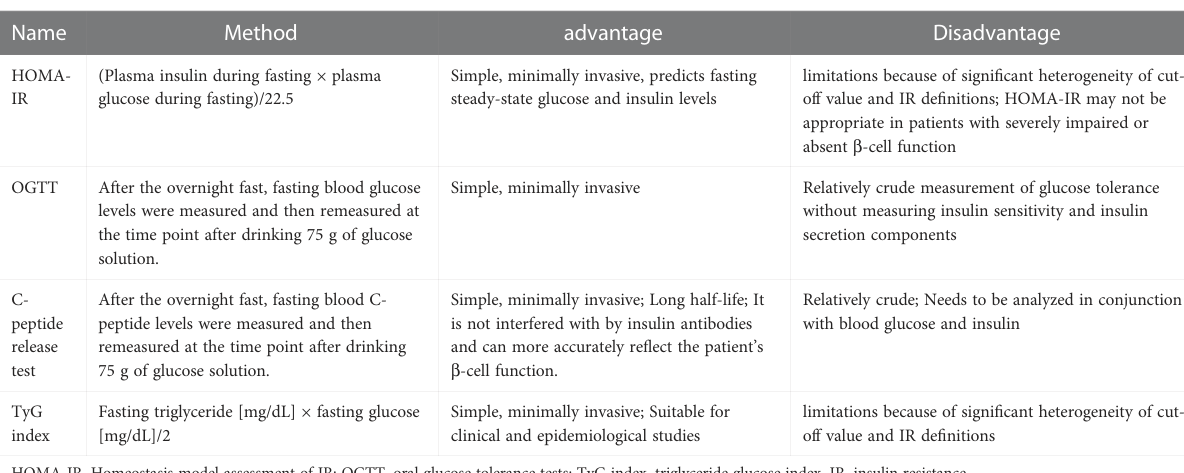
TABLE 1 Four normal methods for assessment of IR in clinical.